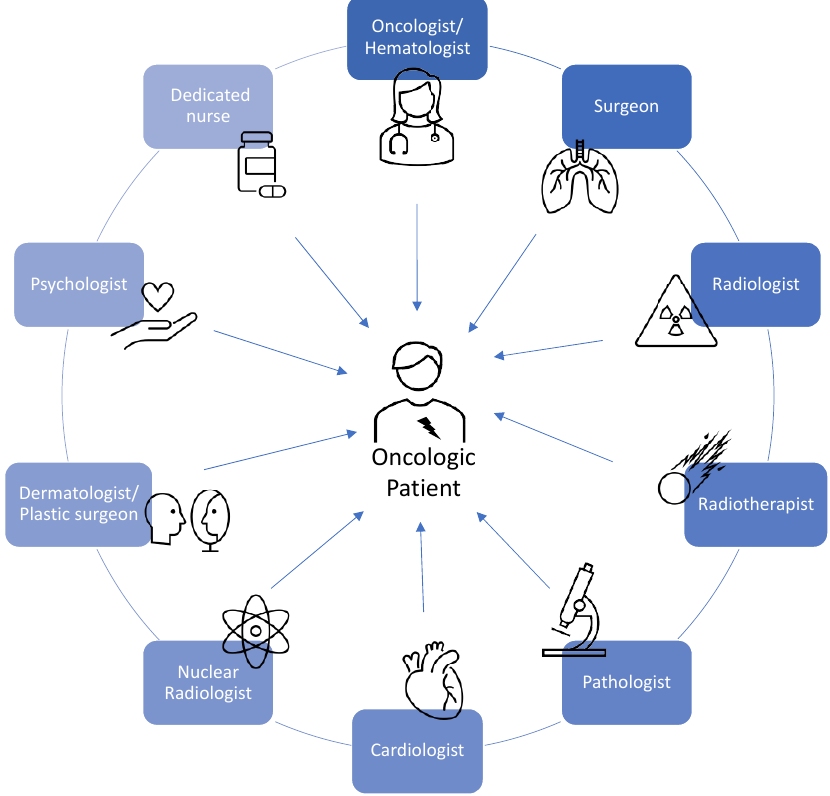
Figure 2. An integrated multidisciplinary approach in management of cancer patients [7].